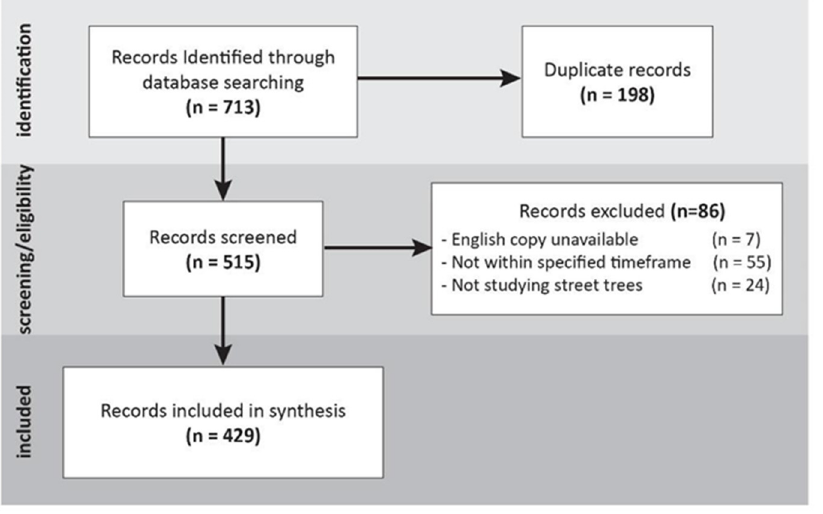
Figure 1. Flow chart outlining the literature databases searched and the article screening, eligibility, and inclusion processes.